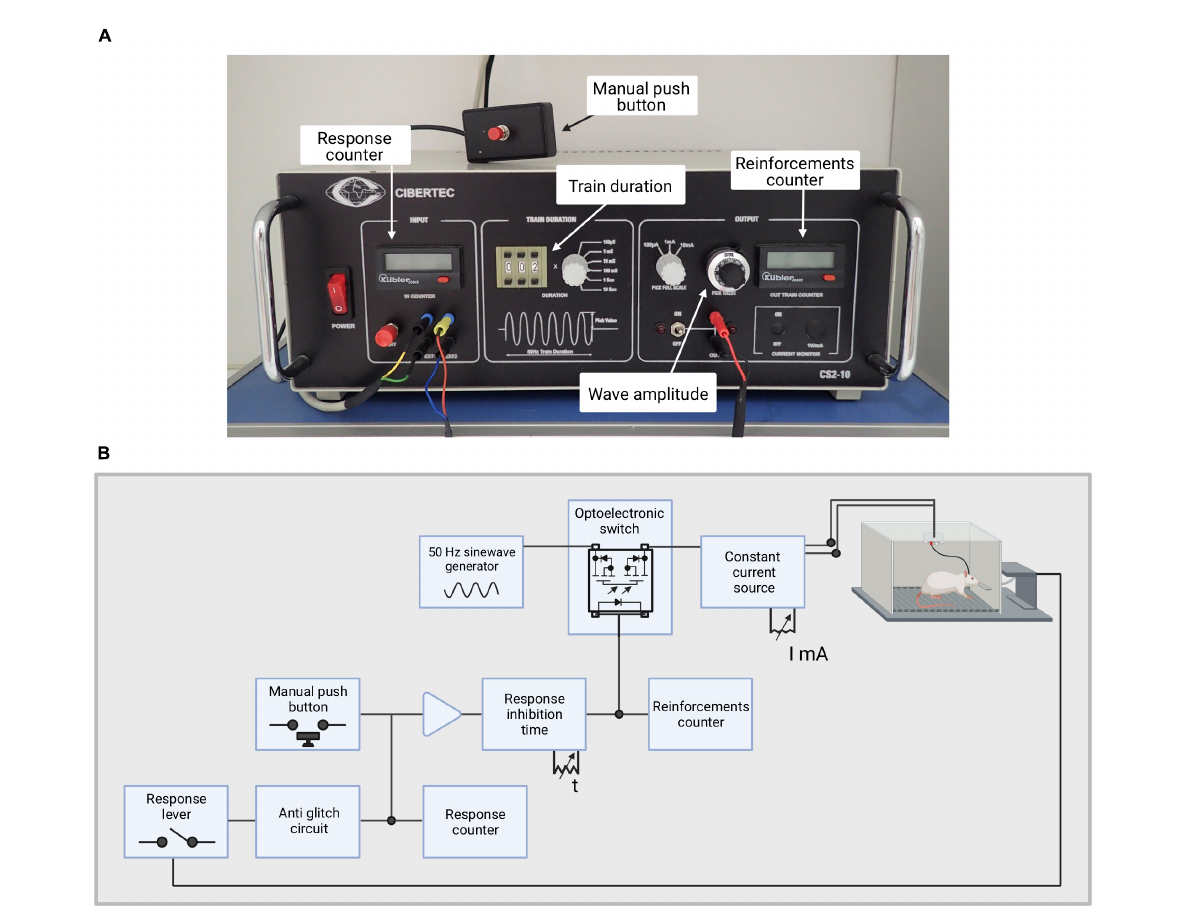
FIGURE4 Stimulator used for this experiment. (A) Picture of the stimulator with its main features depicted. (B) Illustration depicting the stimulator